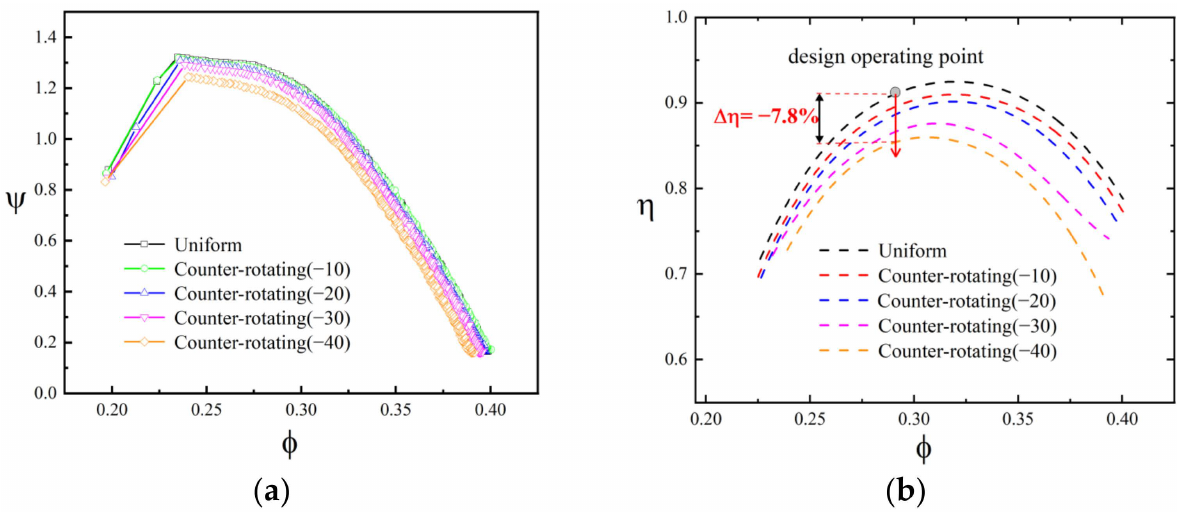
Figure 9. ( a ) Total-to-static pressure rise curves and ( b ) efficiency curves under the inlet counter- rotating bulk swirl distortion.